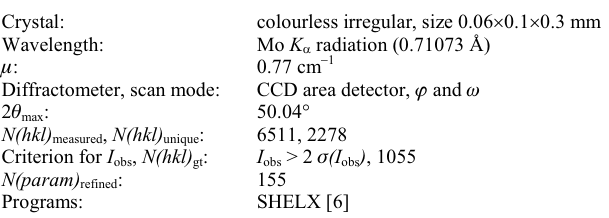
Table 1. Data collection and handling.